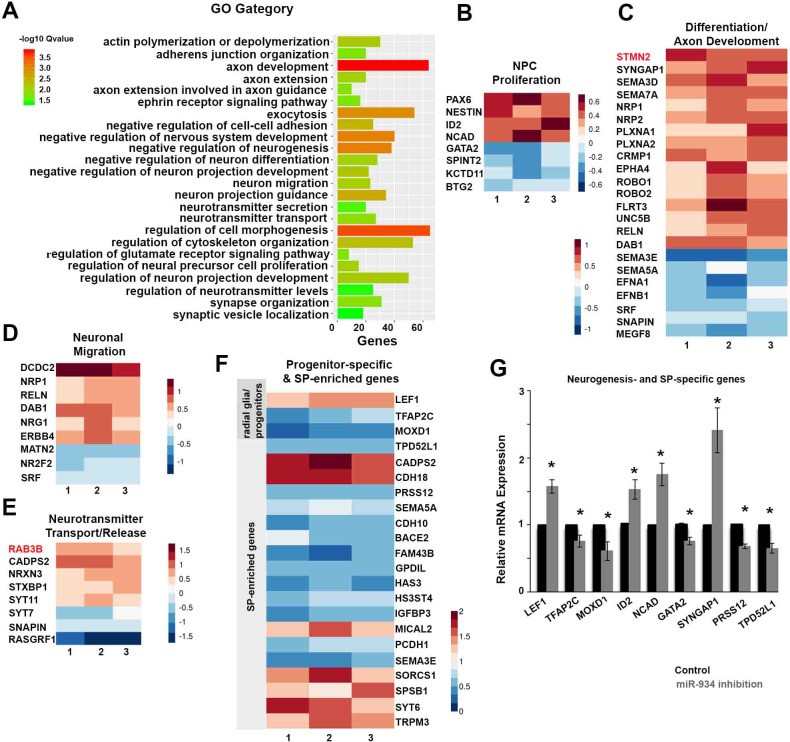
Sustained Inhibition of miR-934 induces global expression changes in genes associated with NPC proliferation and neuronal differentiation.(A) GO enrichment analysis of differential gene expression data following sustained inhibition of miR-934. (B–E) Heatmaps presenting the log2-fold change of molecules involved in the indicated biological processes following miR-934 inhibition, as determined by GO enrichment analysis, from three independent experiments 1, 2 and 3. miR-934 targets STMN2 and RAB3B are depicted in red. (F) Heatmap presenting the log2-fold change of progenitor-specific and SP-enriched genes. Warmer colors indicate higher fold changes. (G) Graph showing qRT-PCR validation data for genes affected by miR-934 inhibition (n = 3–4): LEF1 (scrambled control 1+0.0003 vs miR934 inhibition 1.57+0.09, p=0.009), TFAP2C (scrambled control 1+0.0006 vs miR934 inhibition 0.75+0.08, p=0.04), MOXD1 (scrambled control 1+0.0002 vs miR934 inhibition 0.6+0.14, p=0.04), ID2 (scrambled control 1+0.01 vs miR934 inhibition 1.52+0.14, p=0.03), NCAD (scrambled control 1+0.002 vs miR934 inhibition 1.75+0.17, p=0.01), GATA2 (scrambled control 1+0.01 vs miR934 inhibition 0.75+0.06, p=0.01), SYNGAP1 (scrambled control 1+0.0004 vs miR934 inhibition 2.4+0.33, p=0.02), PRSS12 (scrambled control 1+0.0002 vs miR934 inhibition 0.67+0.03, p=0.002) and TPD52L1 (scrambled control 1+0.0002 vs miR934 inhibition 0.65+0.07, p=0.03). Bars and error bars represent mean values and the corresponding SEMs; 0.01<*p<0.05.Figure 5—source data 1.qRT PCR data for expression of genes affected by miR-934 inhibition.